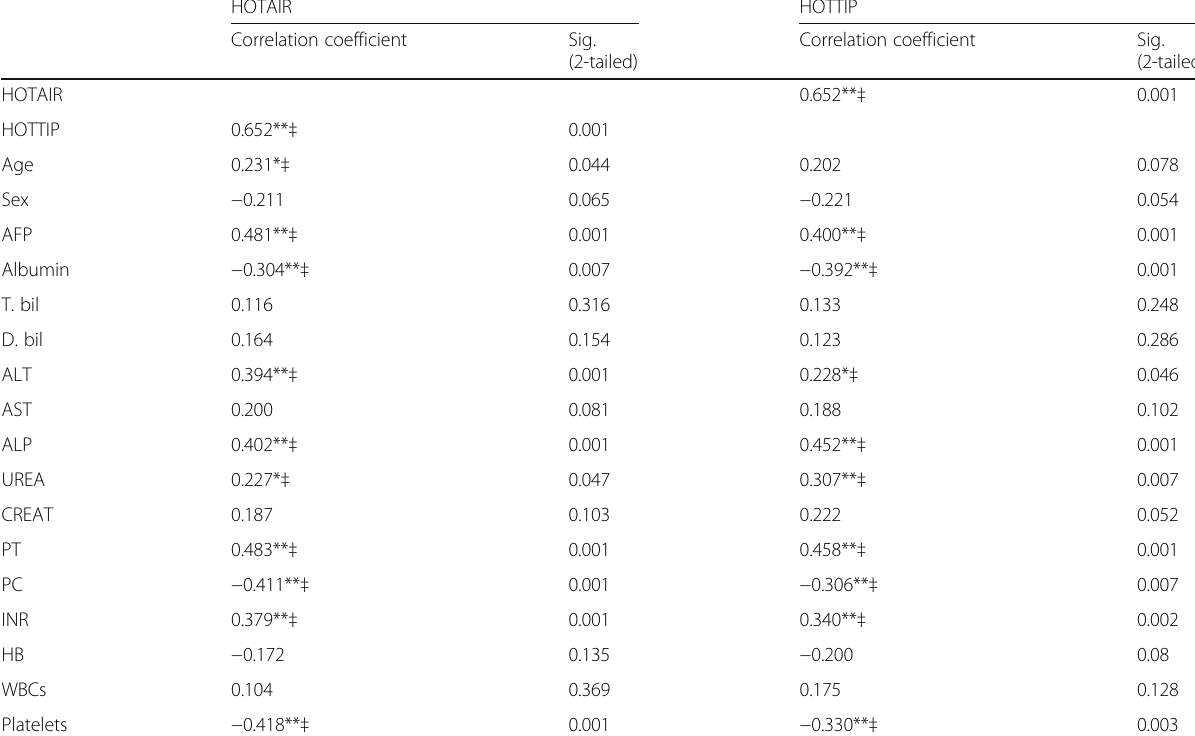
Table 5 Correlation study of the studied